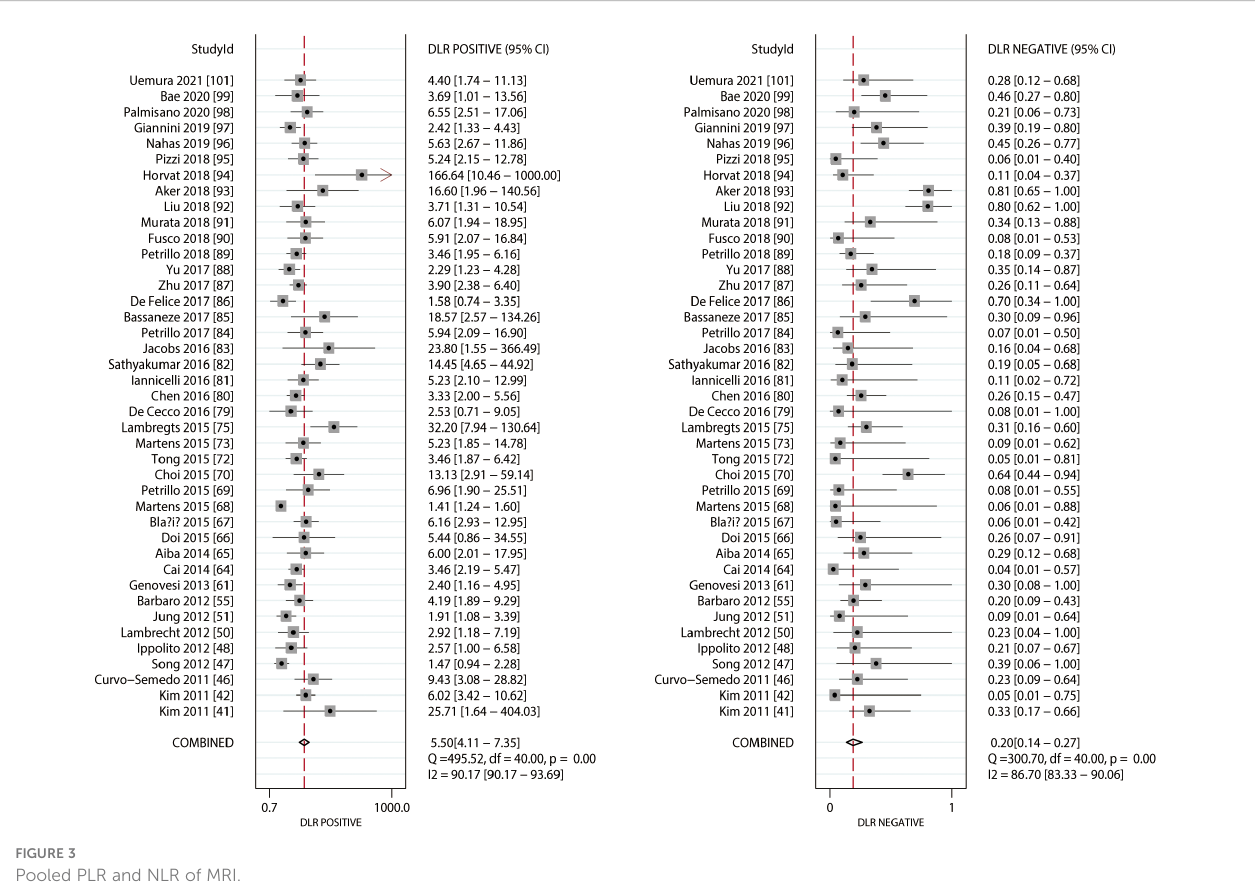
FIGURE 3 Pooled PLR and NLR of MRI.